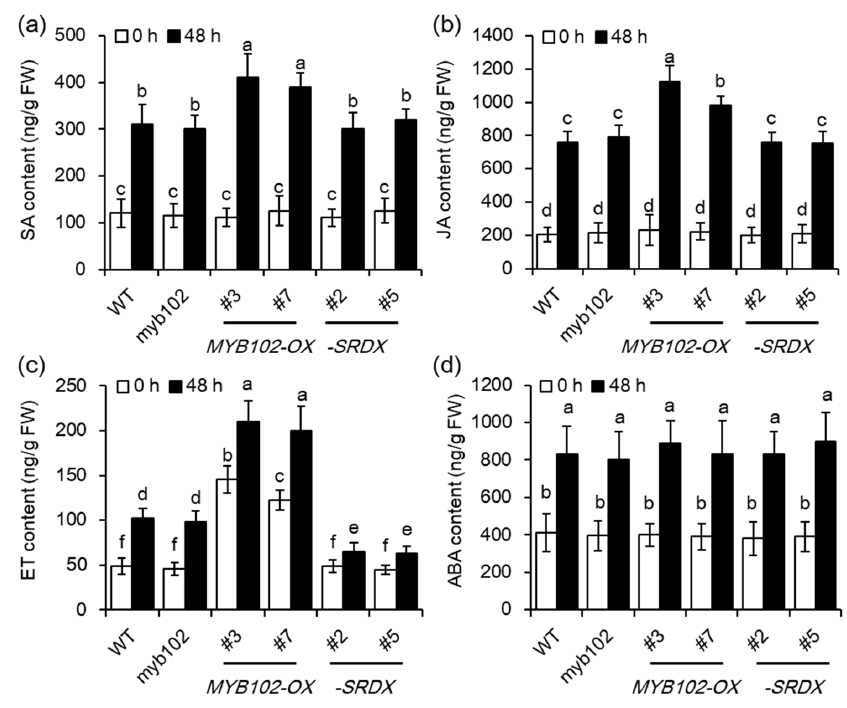
Figure 6. Overexpression of MYB102 increases ethylene (ET) production in uninfested and aphid-infested Arabidopsis plants. The content of salicylic acid (SA) ( a ), jasmonic acid (JA) ( b ), ET ( c ), and abscisic acid (ABA) ( d ) was determined in the WT, myb102 , MYB102-OX and -SRDX lines after zero and 48 h of aphid infestation. At least three replicates were conducted for each genotype. Different letters above bars denotes significant difference among different treatments using Tukey’s test at p < 0.05.